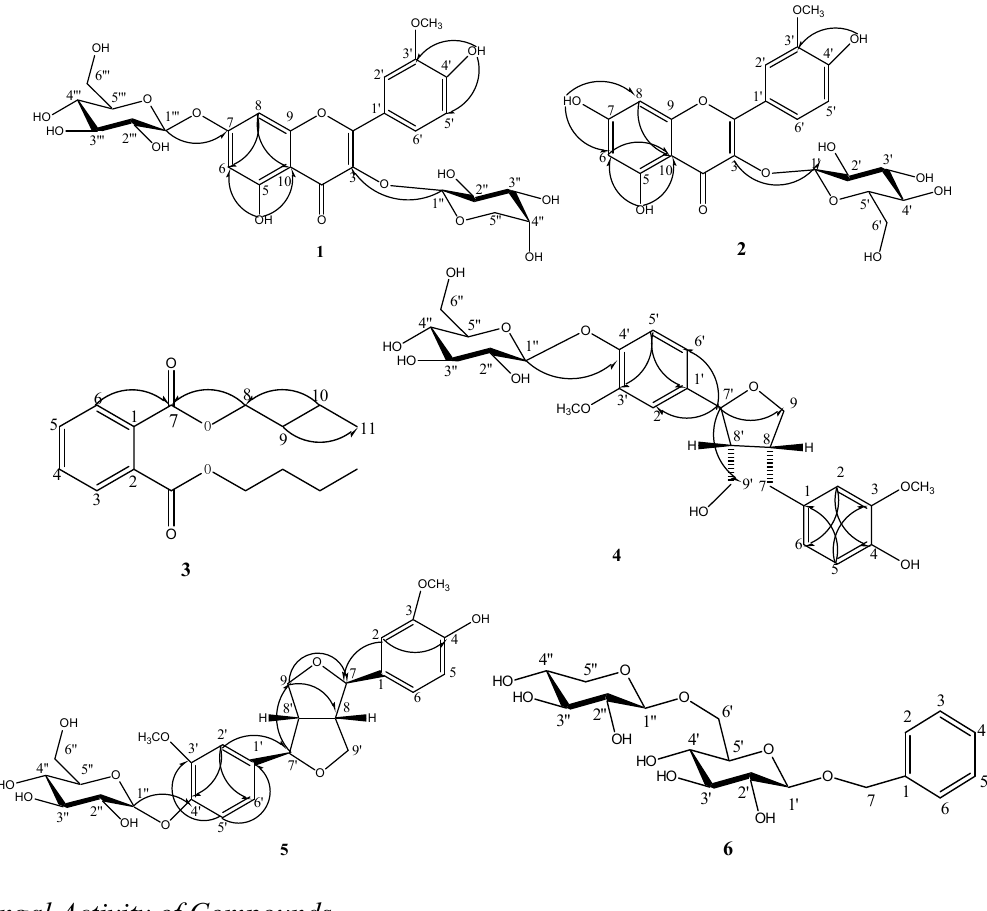
Figure 1. The structure and the key HMBC correlations of compounds 1–6 .